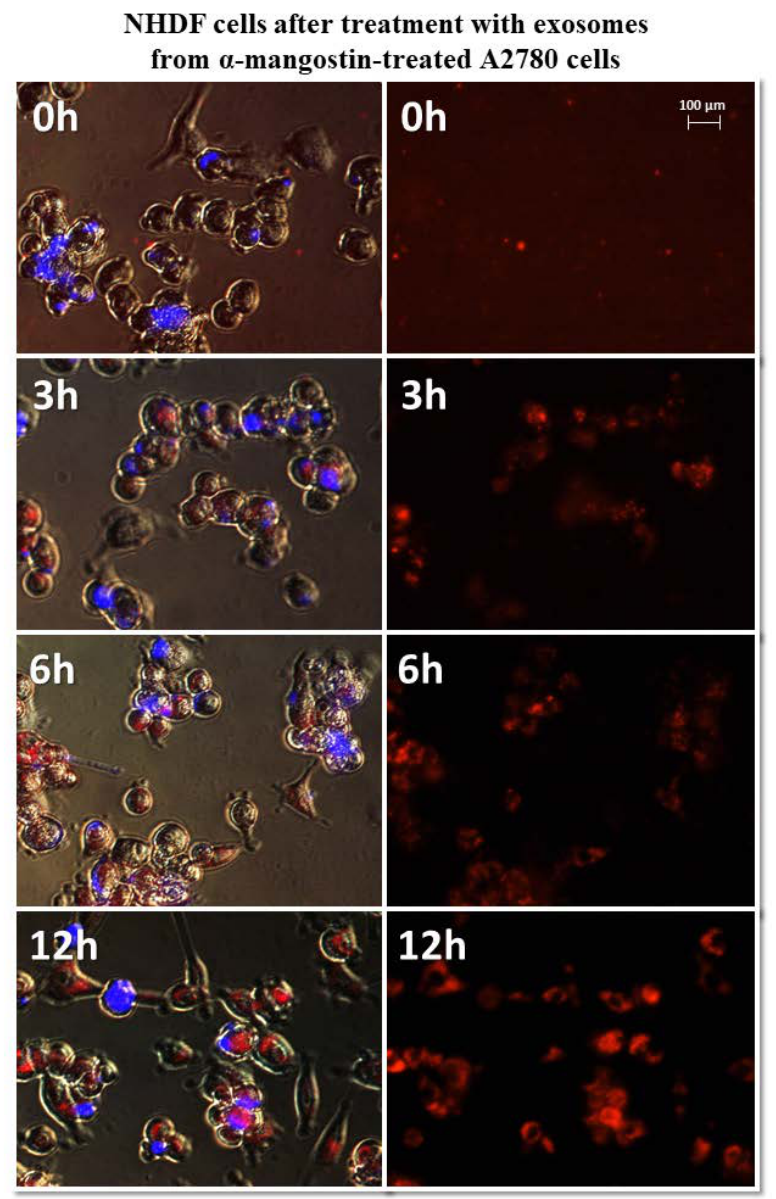
Figure 7. Representative photos of NHDF cells treated with exosomes derived from α -mangostin- treated A2780 cells at 0, 3, 6, and 12 h after treatment. Left: merged images of cells in visible light, DAPI stained cells (blue) and Vybrant™ CM-Dil stained exosomes (red), right: Vybrant ™ CM-Dil stained exosomes (red). Nikon Eclipse Ti, magnification × 20.